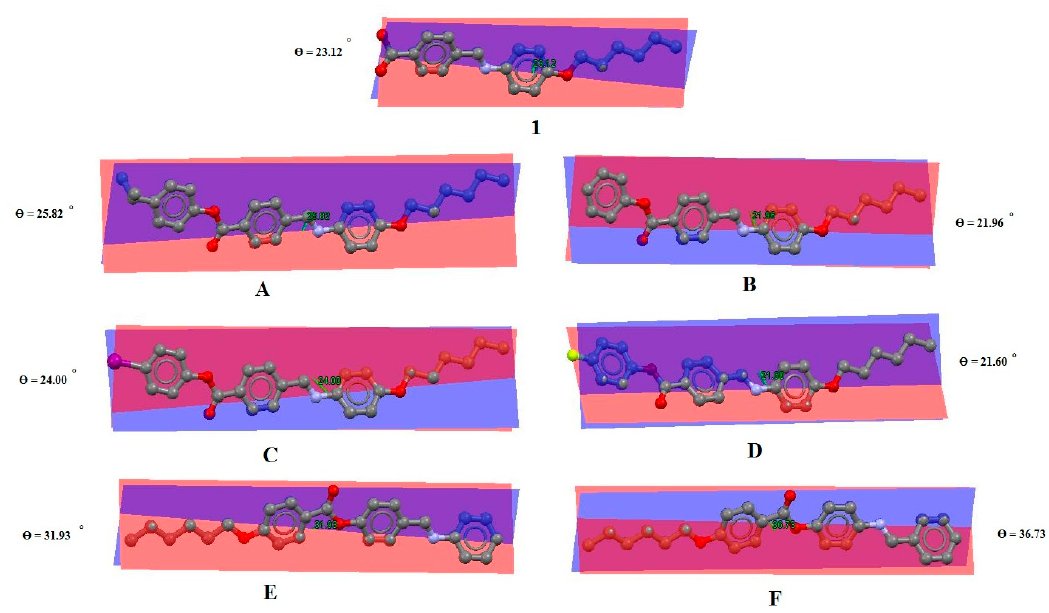
Figure 5. Estimated geometrical structure and twist angles of compounds 1 and A – F . Table 2. Hammett substituent coe ffi cient ( σ ) and the van der Waal volume of terminal X for compounds A – D